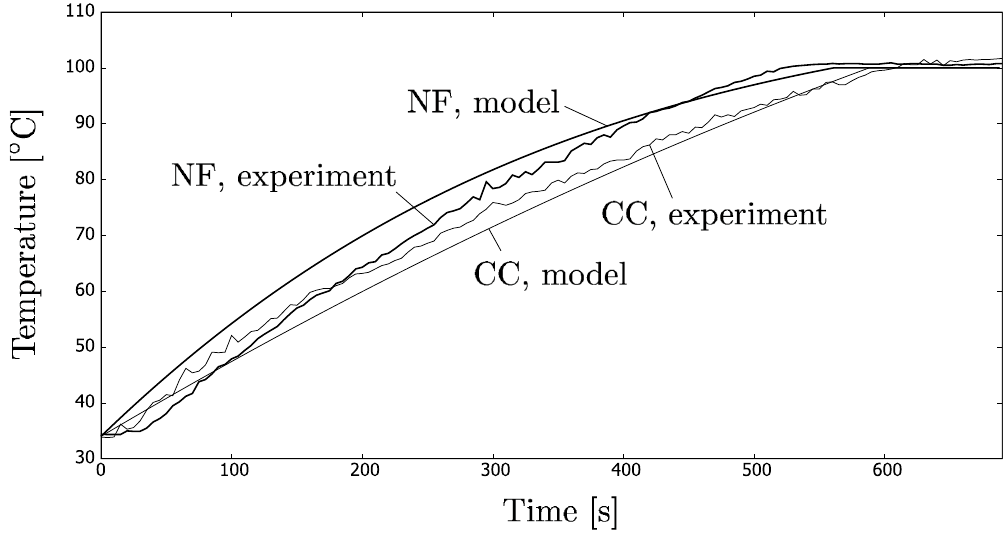
Figure 10. A typical history of fluids temperature during the field experiments using the solar concentrators. The results are compared with the theoretical analysis discussed in “Theoretical analysis” section.